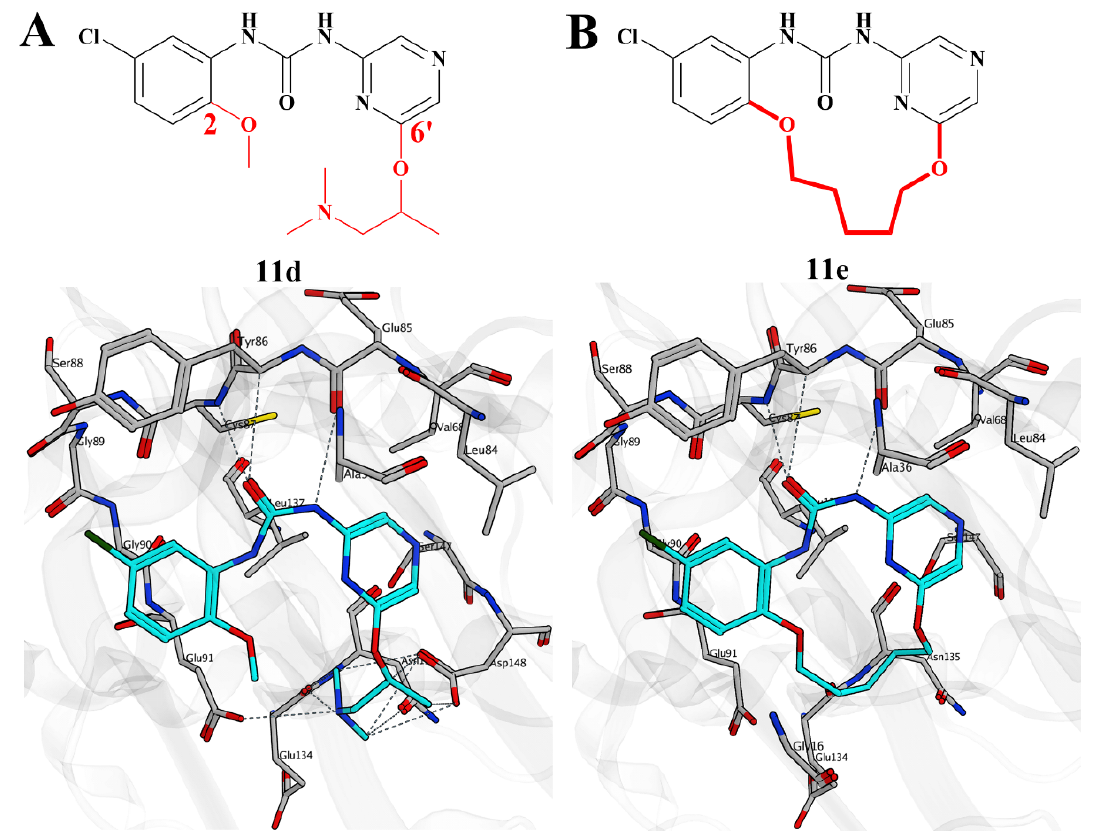
Figure 14. ( A ) X-ray crystal structure of compound 11d bound to Chk1 kinase (PDB: 2E9P). ( B ) X-ray crystal structure of macrocyclic urea 11e bound to Chk1 kinase (PDB: 2E9U).